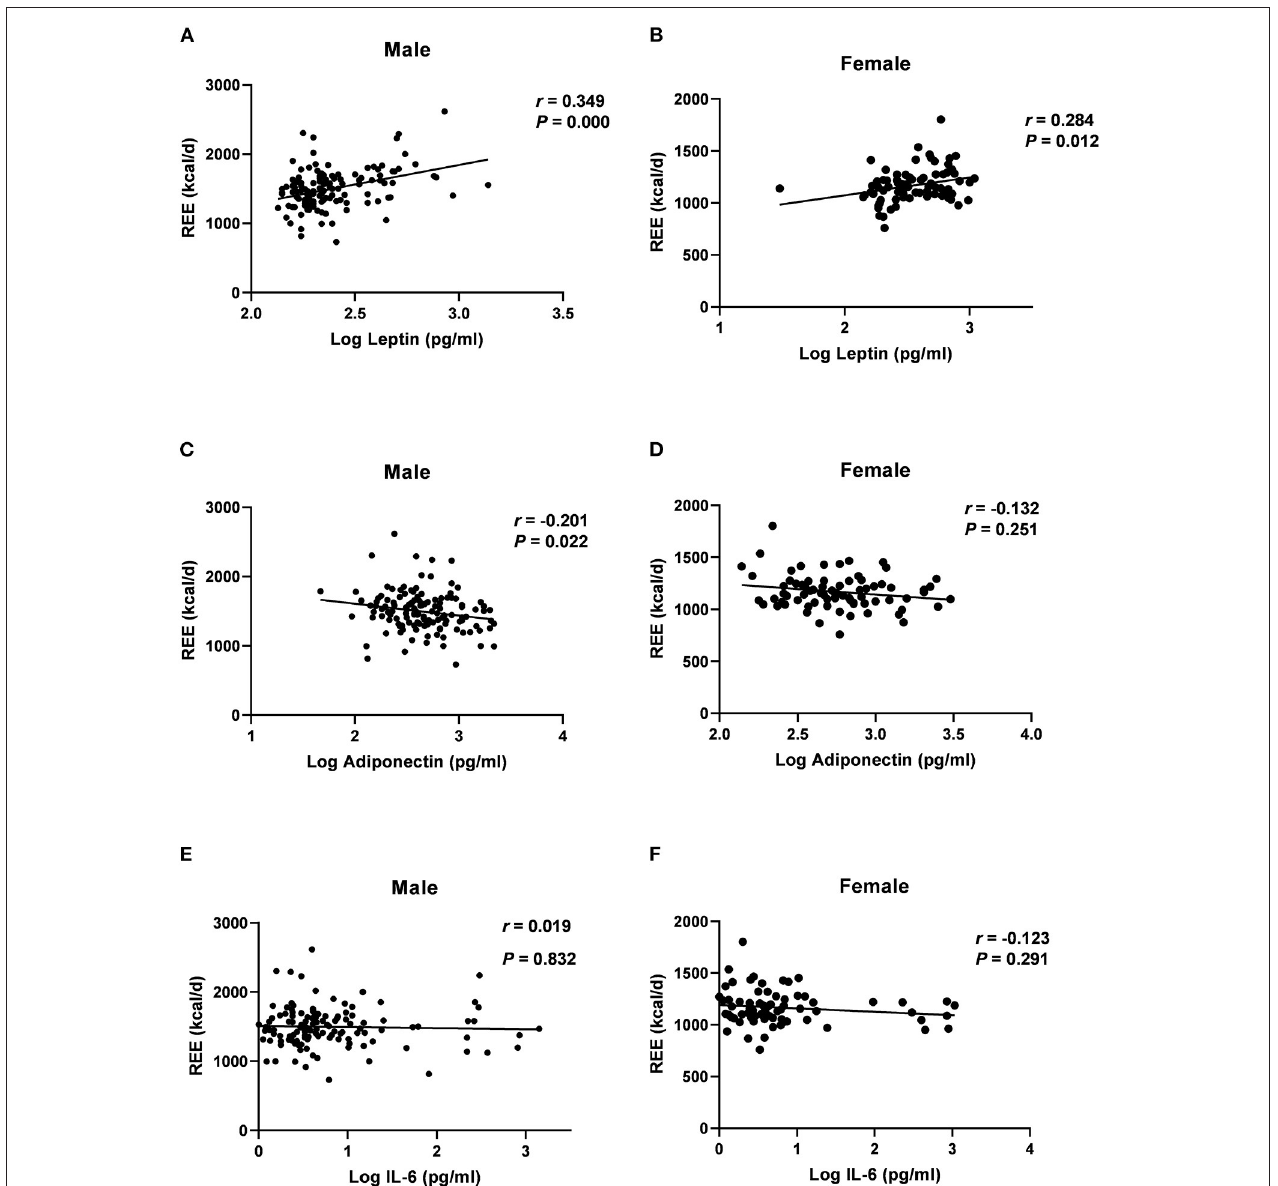
FIGURE 2 | Correlations of log-transformed adipokines level with REE in males and female groups, assessed by Log leptin (A,B) ; Log adiponectin (C,D) ; Log IL-6 (E,F) ; REE, resting energy expenditure; IL, Interleukin; r, Spearman’s rank correlation